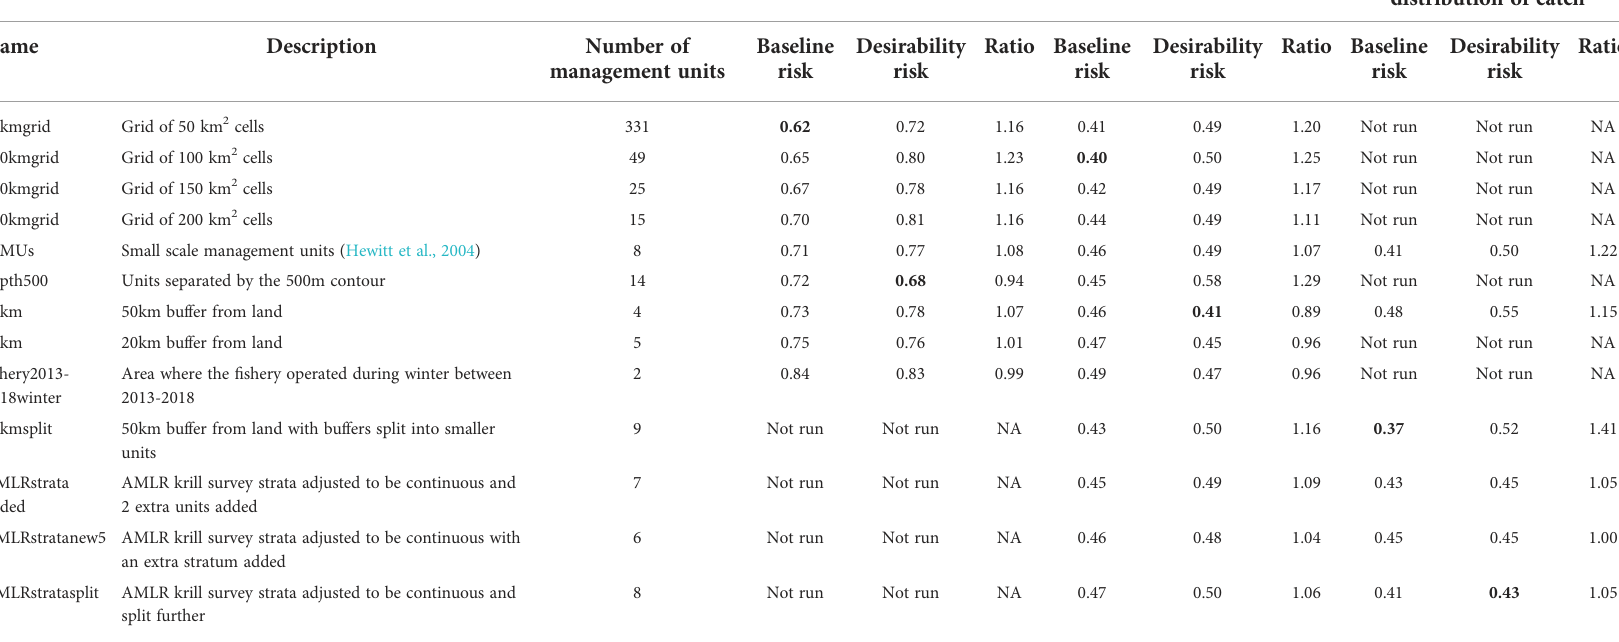
TABLE 1 A selection of scenarios detailing the relative risk from each candidate management scenario assuming the proportion of catch is taken from each management unit as detailed in Appendices 2 – 4